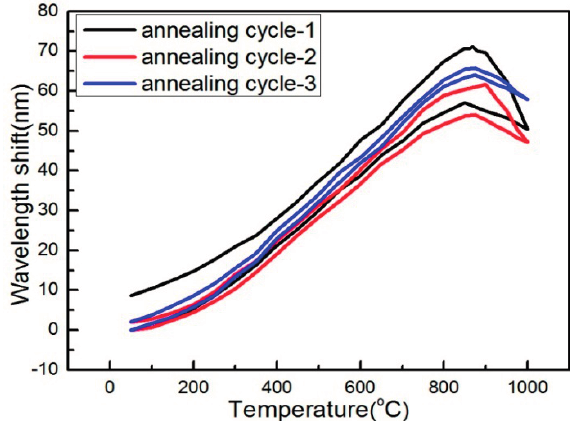
Figure 9. Wavelength responses of MZI sensor under several heating and cool temperature cycles (from 25 °C to 1000 °C).